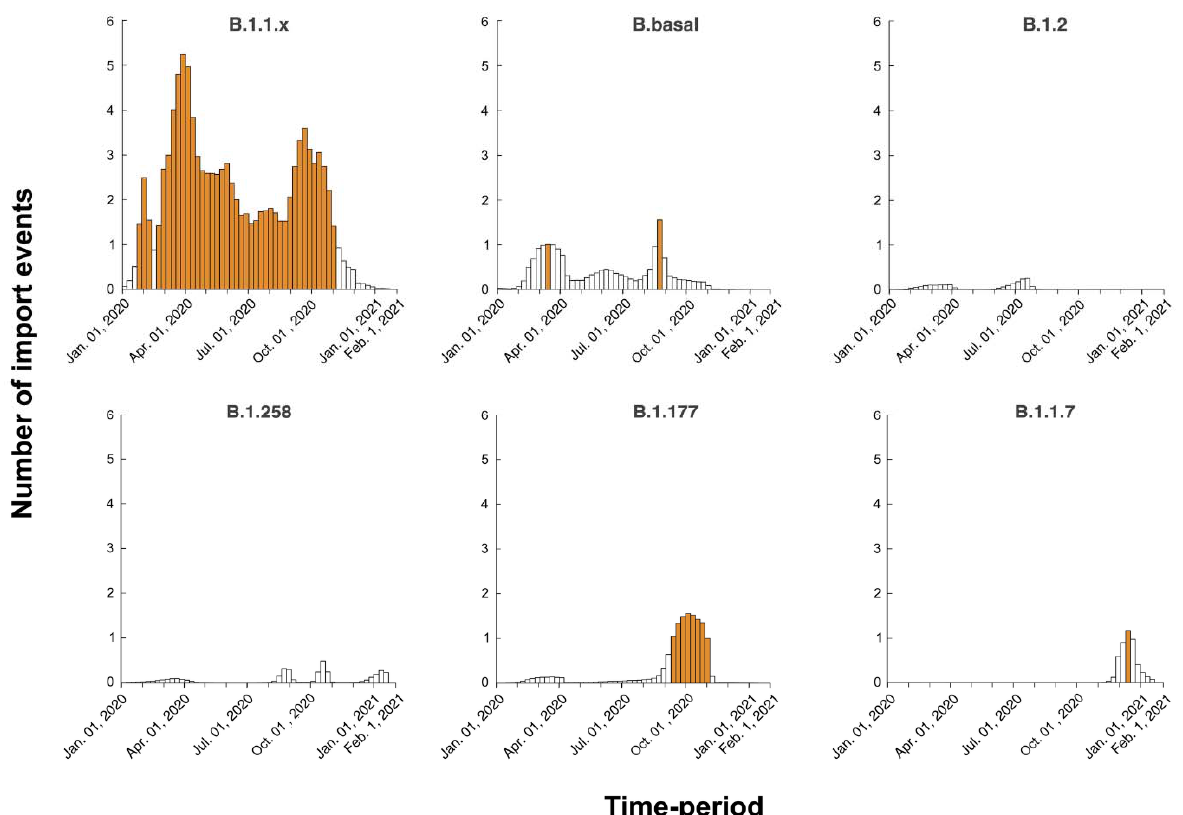
Figure 11. Temporal dynamics of SARS-CoV-2 introduction into Cyprus. The width of each bar corresponds to one week, and the height corresponds to the number of times that a migration event into Cyprus was inferred to have occurred in that week, averaged over the post-burn-in states sampled during the Markov Chain Monte Carlo (MCMC) integration. Weeks during which more than one import event was inferred are colored orange. The y -axis represents the number of import events per week, while the x -axis represents the sampling time-period from January 2020 to January 2021.